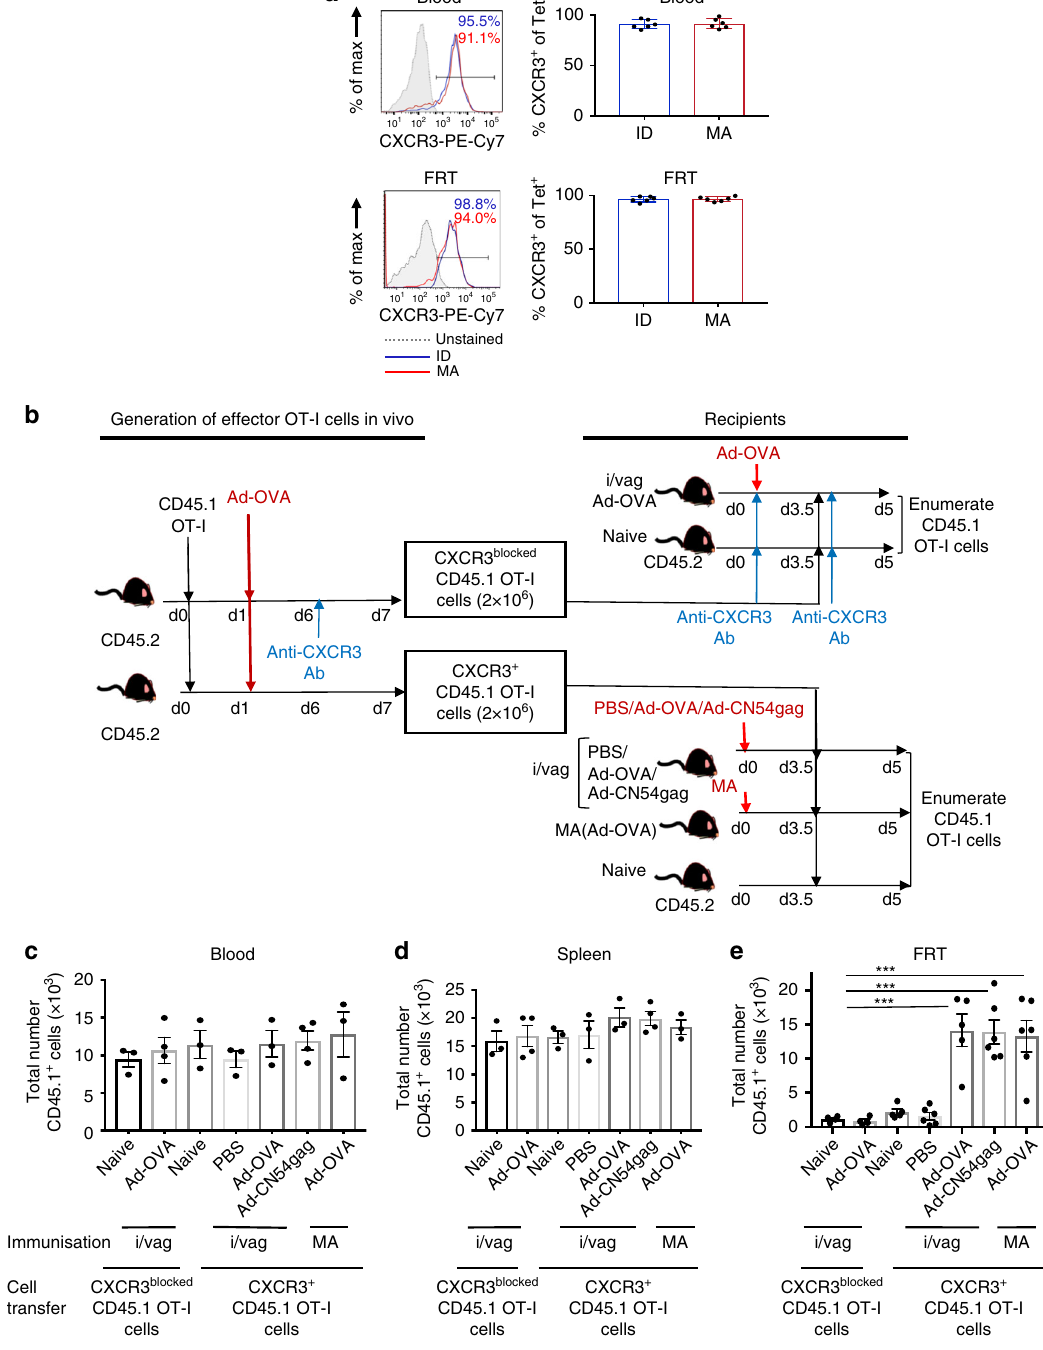
Fig. 4 CXCR3 is essential for recruitment of CD8 + T cells to FRT, independent of antigen speci fi city. a Representative fl ow-cytometry pro fi les and graphs showing frequency of CXCR3 + D b /CN54 gag tet + cells in blood (upper panels) and FRT (lower panels) 14 days after skin immunisation; ID (blue histograms) or MA (red histograms); grey- fi lled histograms represent unstained control, all gated from a CD45 + CD4 − MHCII − CD8 + population. Bar graphs summarise data from two independent experiments ( n = 6 for experimental groups). b Experimental design. Congenic CD45.1 OT-I cells (2